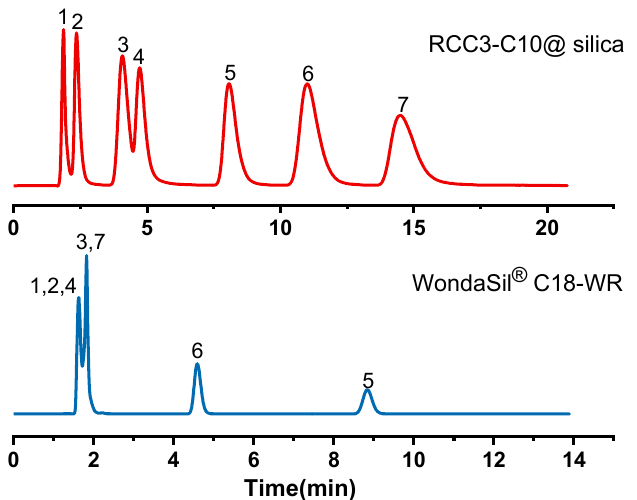
Figure 4. Chromatogram of nucleosides, flavonoids and sulfonamides on the RCC3-C10@silica molecular cage column and WondaSil ® C18-WR column. Analytes: (1) cytidine, (2) sulfanilamide, (3) naringin, (4) inosine, (5) flavanone, (6) 6-hydroxyflavanone, (7) sulfadimidine. Mobile phase: 70% methanol/water ( v / v ); Flow rate: 1.0 mL/min; UV: 254 nm.